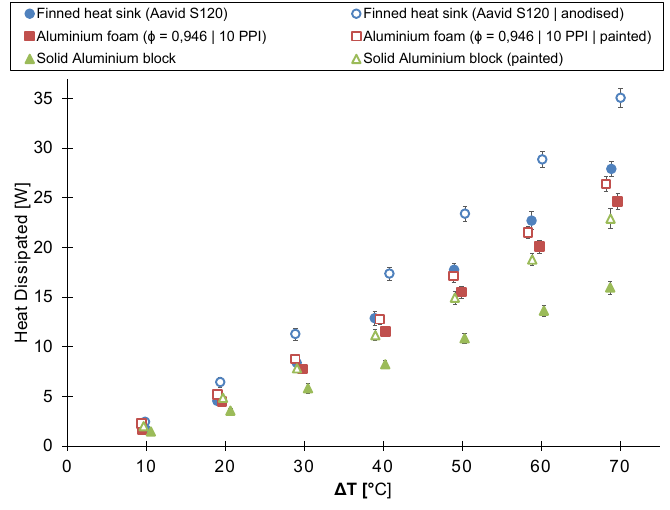
Figure 8. The heat dissipated by the untreated and the painted/anodized heat sink as a function of the temperature difference between the ambient air and the heat sink’s base plate (heat sink’s height = 22